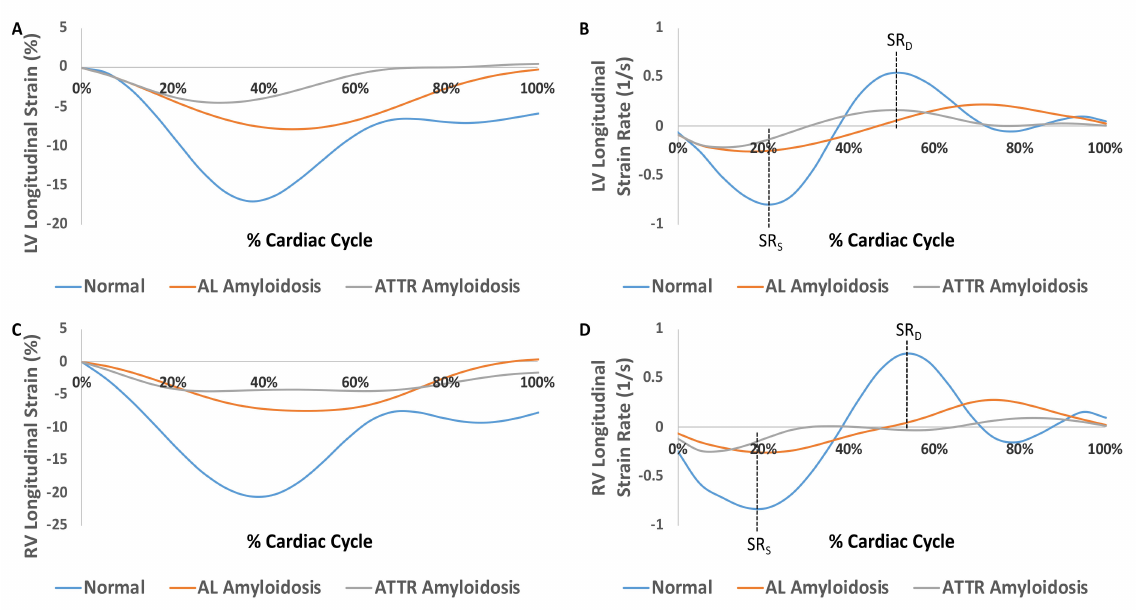
Figure 4. Strain curves illustrating left ventricular (LV) and right ventricular (RV) changes in global longitudinal strain and strain rate over the course of one cardiac cycle. Representative strain curves were used from a normal patient, an AL amyloidosis patient, and an ATTR amyloidosis patient. ( A ) LV longitudinal strain curves; ( B ) LV longitudinal strain rate curves; ( C ) RV longitudinal strain curves; ( D ) RV longitudinal strain rate